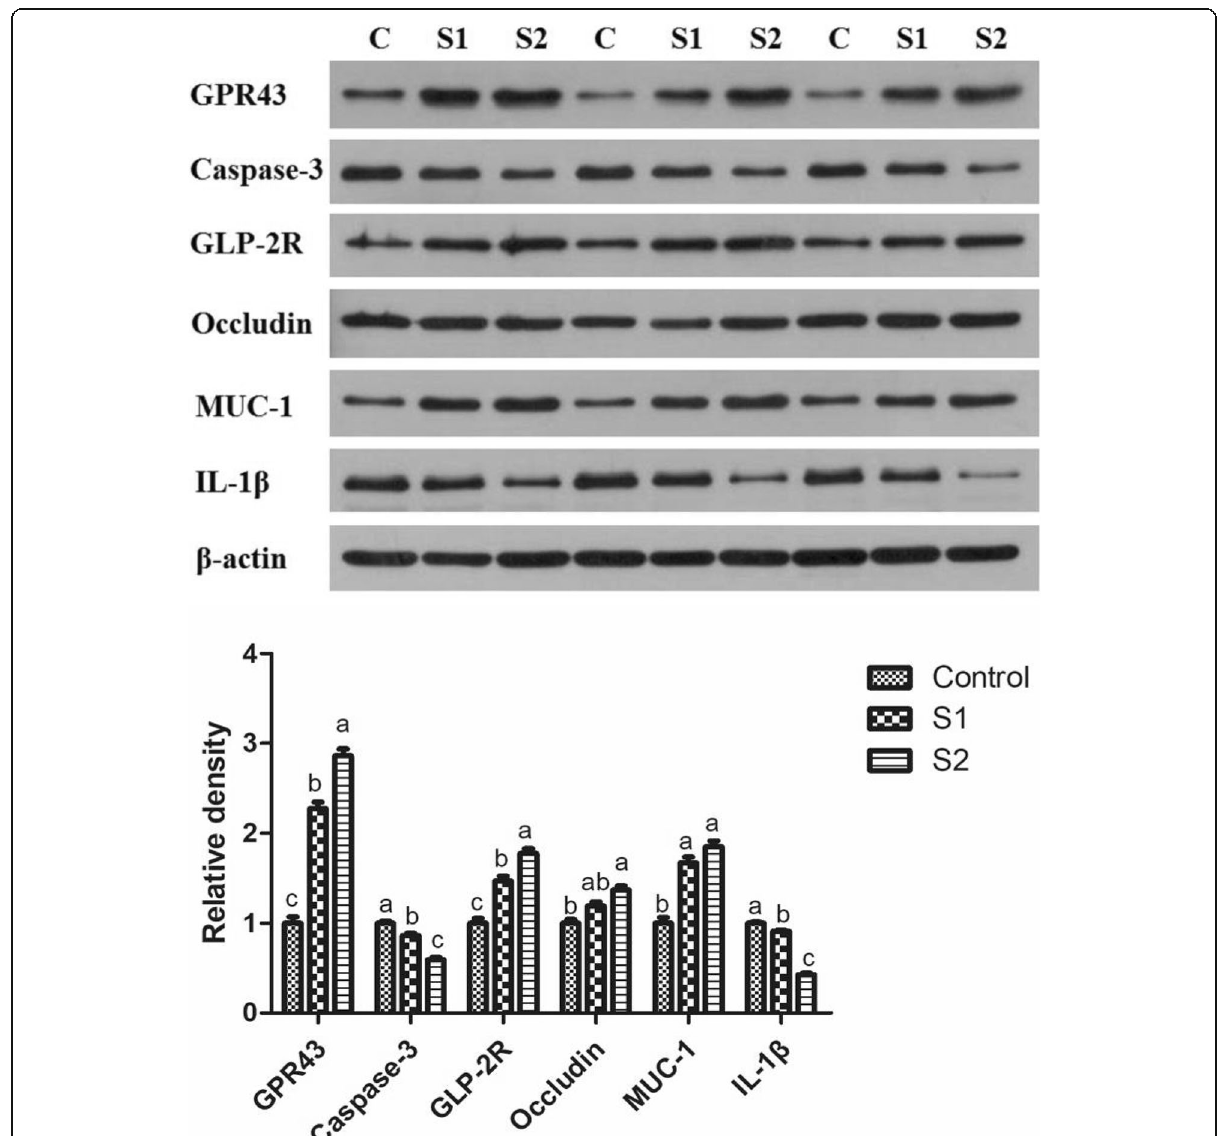
Fig. 7 Effect of gastric infusion of SCFA on the protein levels of GPR43, Caspase-3, GLP-2, Occludin, MUC-1, and IL-1 β in jejunum of weaned piglets. S1, pigs treated with SCFA (acetic, propionic, and butyric acids; 20.04, 7.71, and 4.89 mM respectively); S2, pigs treated with SCFA (acetic, propionic, and butyric acids; 40.08, 15.41, and 9.78 mM respectively). a, b, means without a common superscript differ ( P <